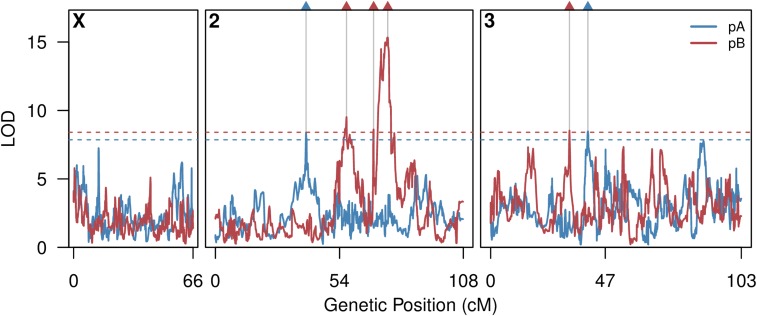
Genome-wide scan for boric acid resistance QTL in the DSPR. Solid lines depict population-specific scans across the major D. melanogaster chromosomes. Horizontal dashed lines represent permutation-derived 5% critical thresholds (pA, 7.9; pB, 8.4). Autosomal centromeres are shown at positions 54 cM (chromosome 2) and 47 cM (chromosome 3). The locations of the six mapped QTL are highlighted along the top of the plot, with colors indicating population (left-to-right; pA.Q1, pB.Q1, pB.Q2, pB.Q3, pB.Q4, and pA.Q2). DSPR, Drosophila Synthetic Population Resource; QTL, quantitative trait loci.